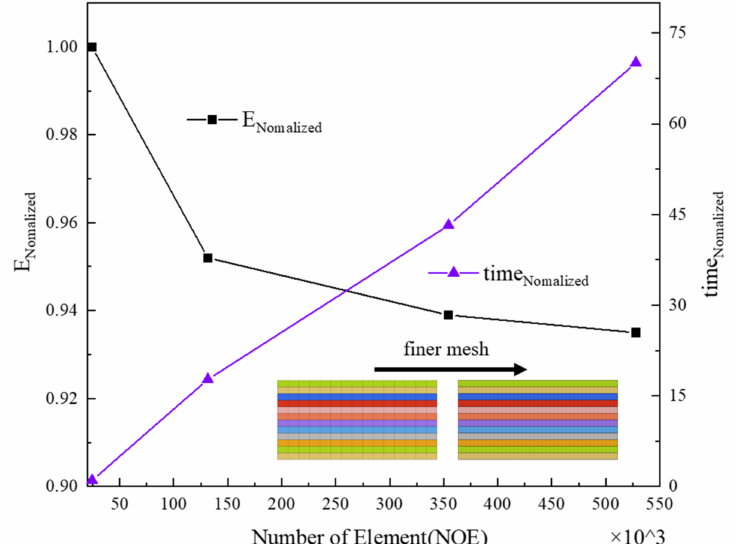
Figure 7. Normalized moduli and computing time as a function of element